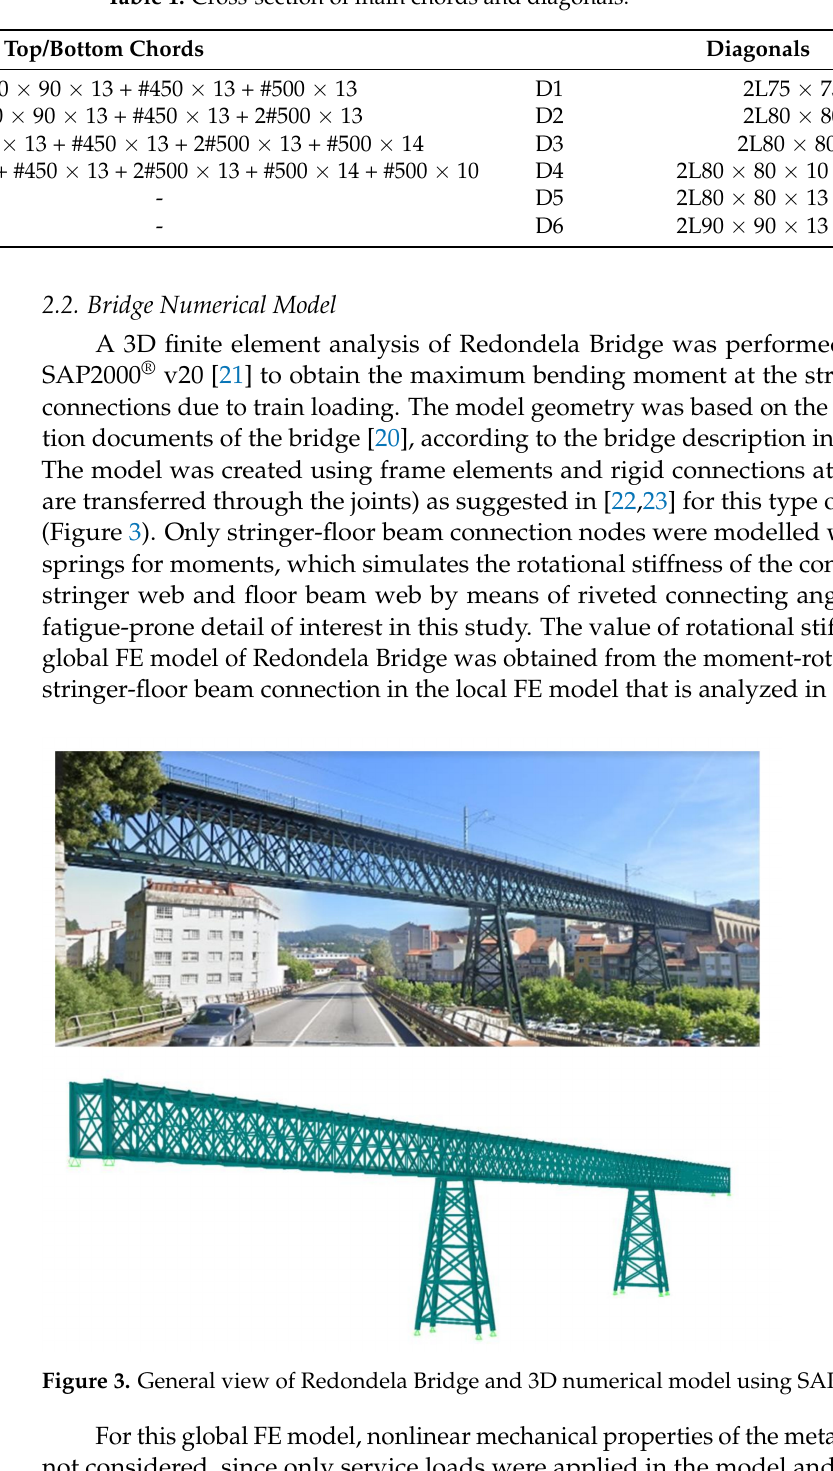
Table 1. Cross-section of main chords and diagonals.